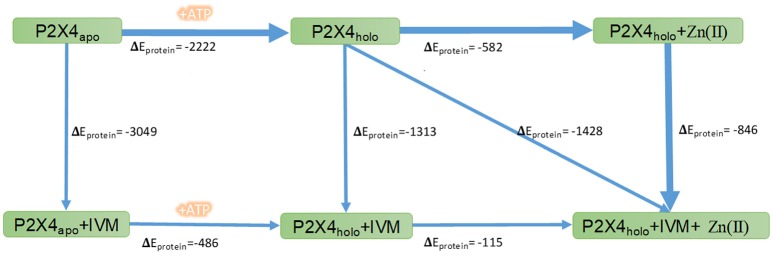
Non-bonded energy determination of the P2X4R in different states. Numbers indicate the changes in non-bonded energies, expressed as kcal/mol, of the whole wtP2X4R (ΔEprotein) in the different conformational complexes of the P2X4R. The rectangles indicate P2X4R states in the apo or holo state alone or following allosteric modulator binding. The arrows refer to the transition between the different states. The thicker blue lines indicate the favored P2X4R transitions after allosteric modulator binding.